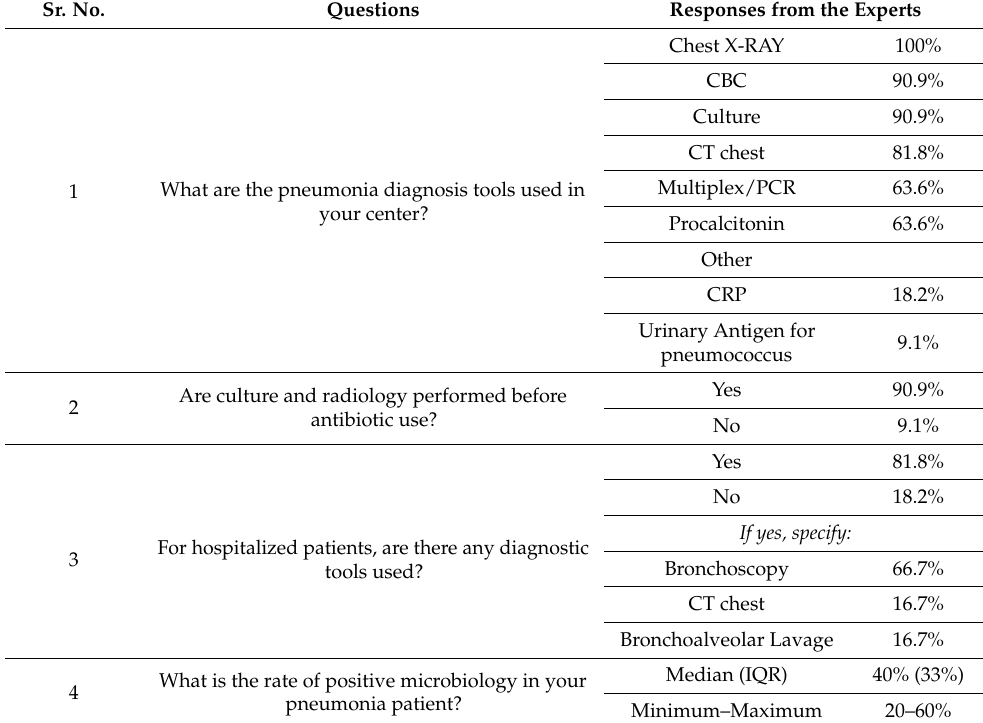
Table 2. Expert opinion on the diagnosis of